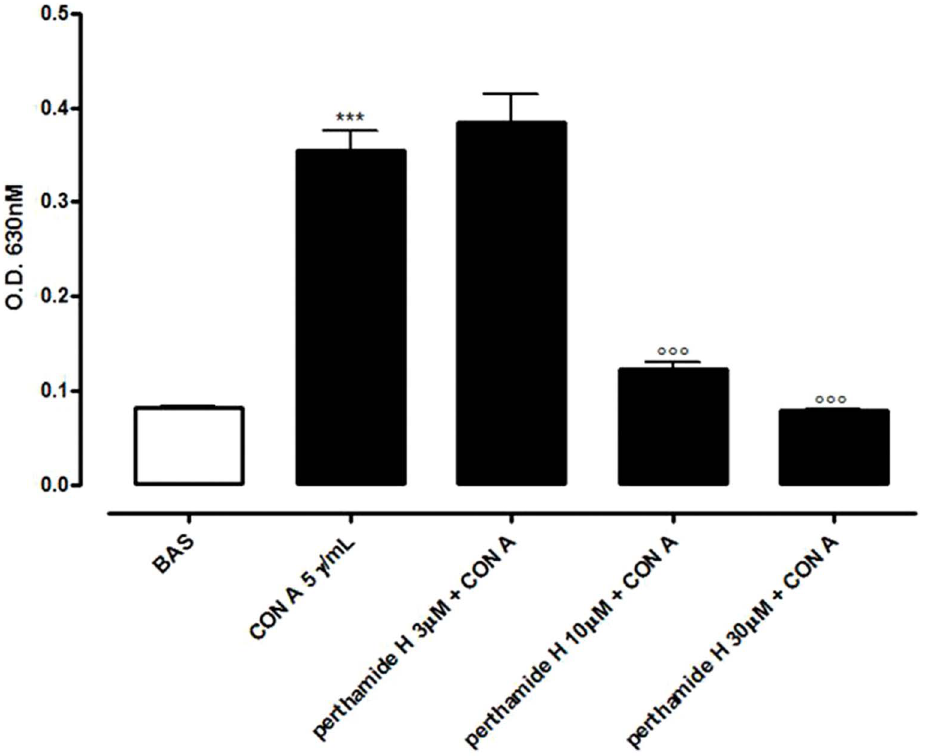
Figure 6. Proliferation assays on lymphocytes harvested from na¨ive mice. Perthamide H significantly inhibited, in a dose-dependent manner, Con A-induced proliferation of lymphocytes. Values are means 6 SEM of three separate experiments with n=5–6 mice. *** P , 0.001 vs basal (Bas); uuu P , 0.001 vs Con A. doi:10.1371/journal.pone.0057801.g006 PLOS ONE |